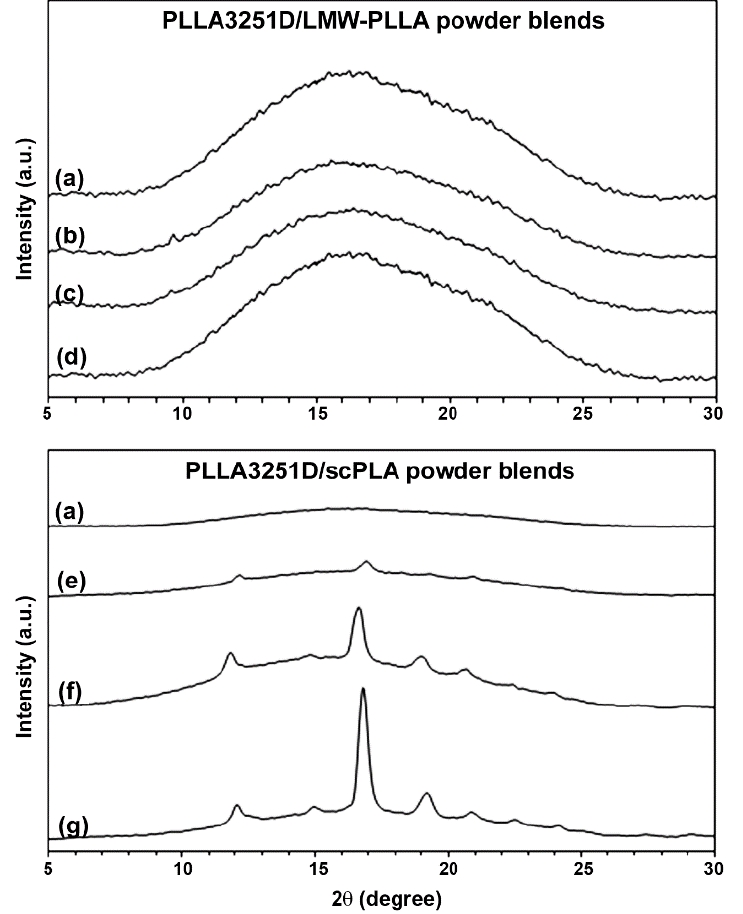
Figure 9. XRD patterns of ( a ) pure PLLA3251D and PLLA3251D/LMW-PLLA powder blend films with powder contents of ( b ) 2%, ( c ) 4%, and ( d ) 8% w / w as well as PLLA3251D/scPLA powder blend films with powder contents of ( e ) 2%, ( f ) 4%, and ( g ) 8% w / w .